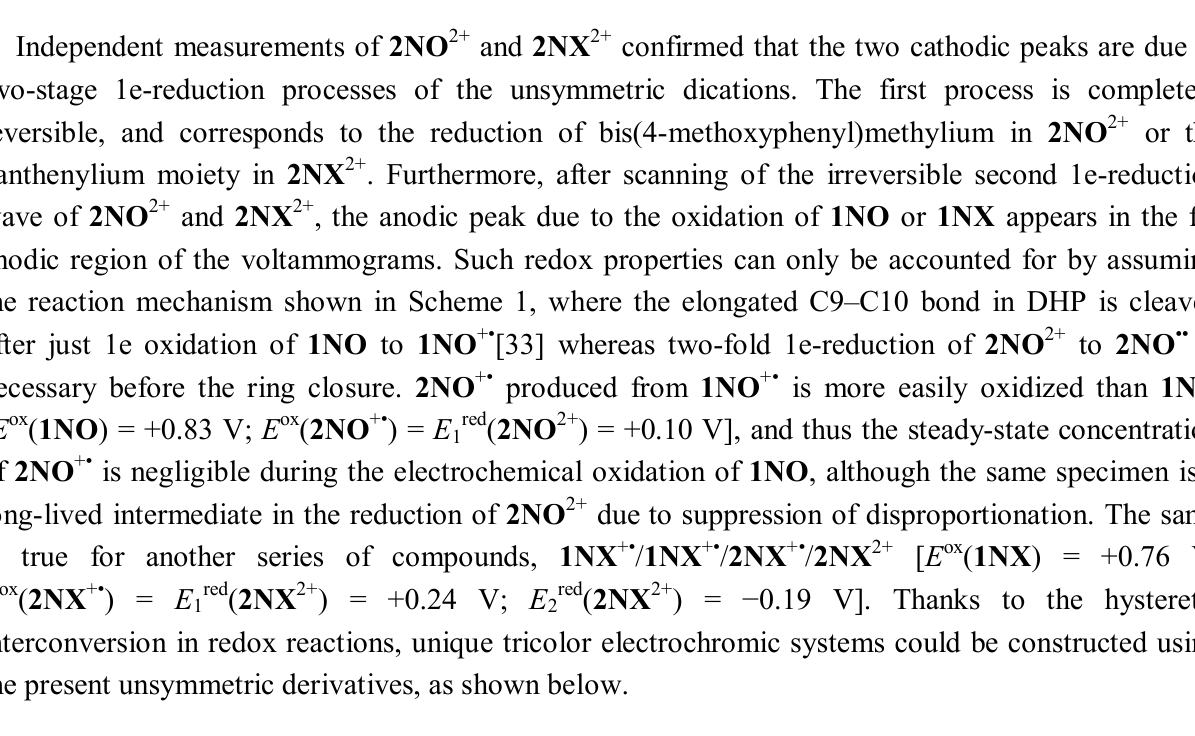
Cl ( E /V vs . SCE 0.1 M 2 2